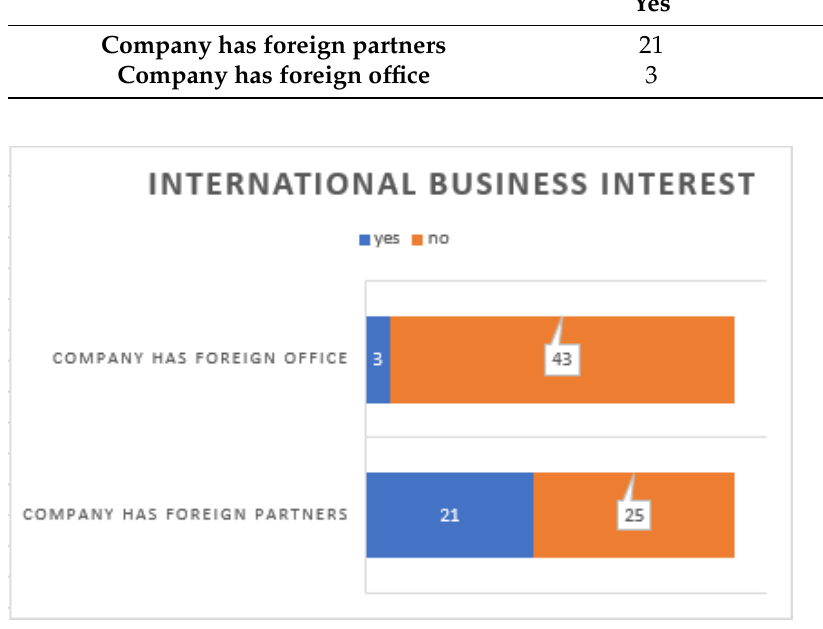
Figure 13. International business contacts.